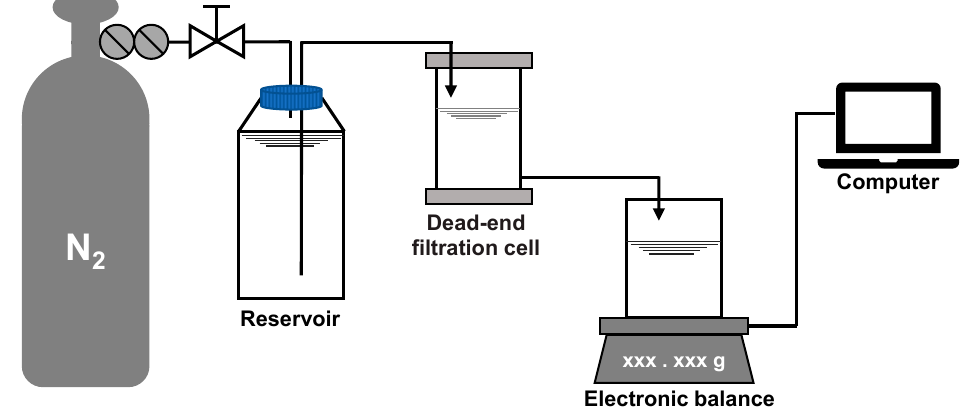
Figure 2. Layout of the dead-end filtration system.